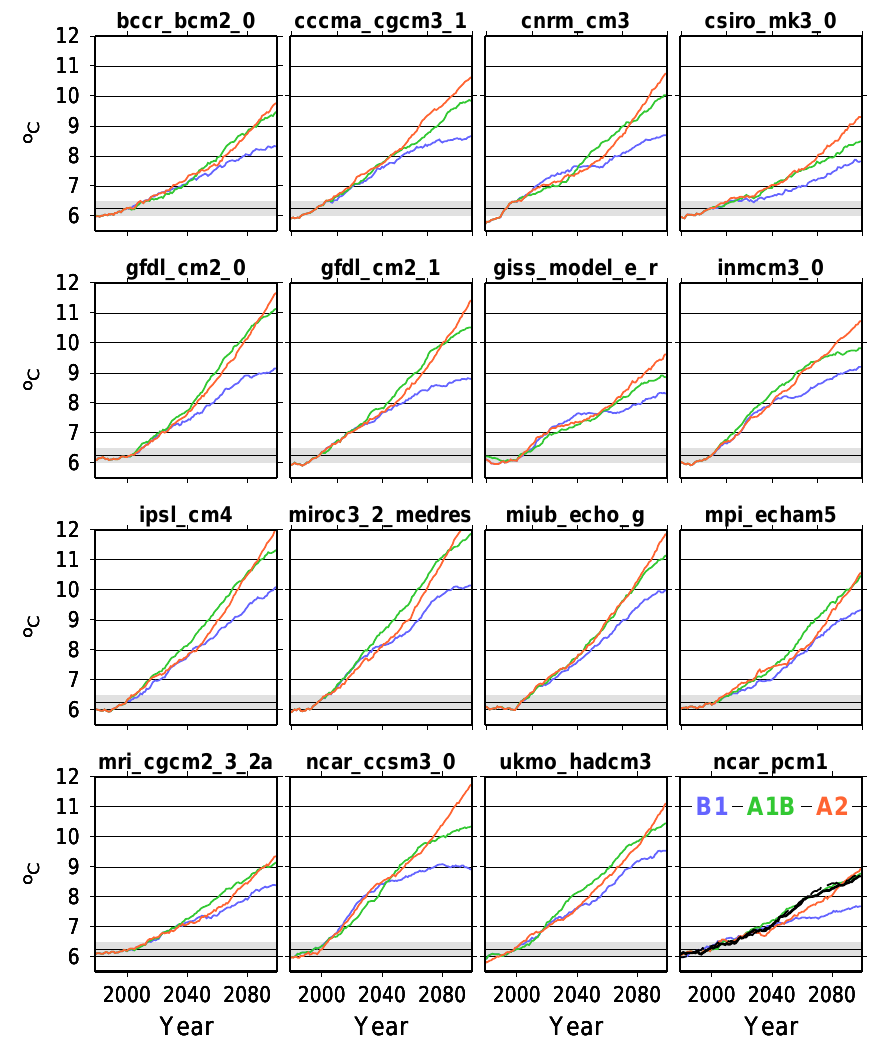
Fig. 10. Time evolution of projected 30-yr averages (trailing) of temperature upstream of Lees Ferry, AZ. Projections are color-coded by emissions pathway (see bottom right panel), with the exception of two runs that are highlighted for the NCAR PCM1 model (see text).